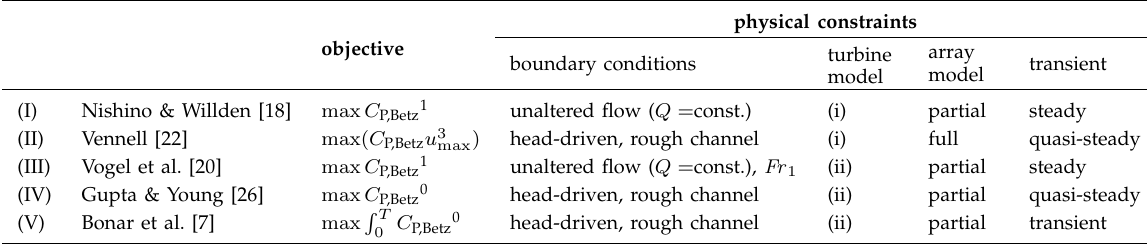
TABLE I A RRAY MODELS VIEWED FROM AN OPTIMISATION PERSPECTIVE .